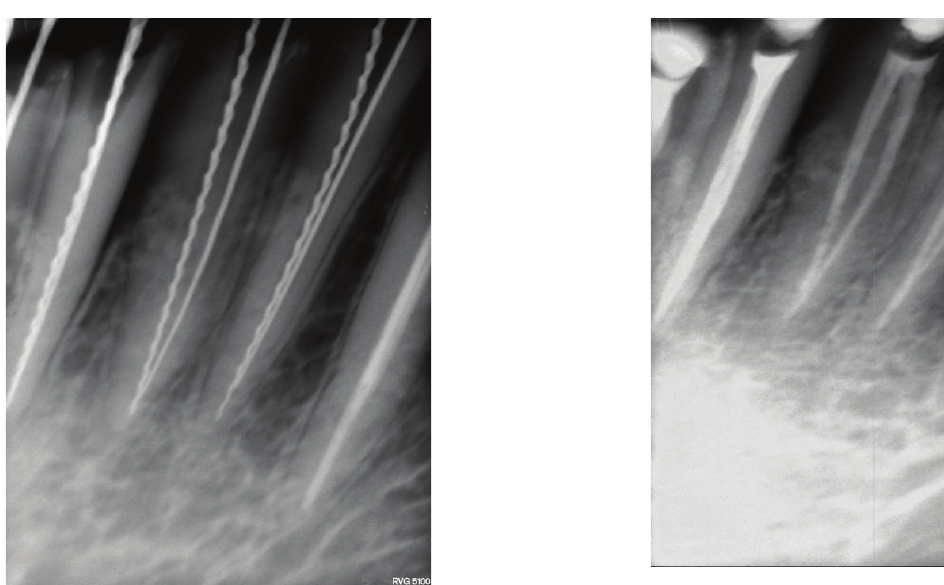
Figure 7: Radiograph showing obturation in two separate canals in 41 and 42.